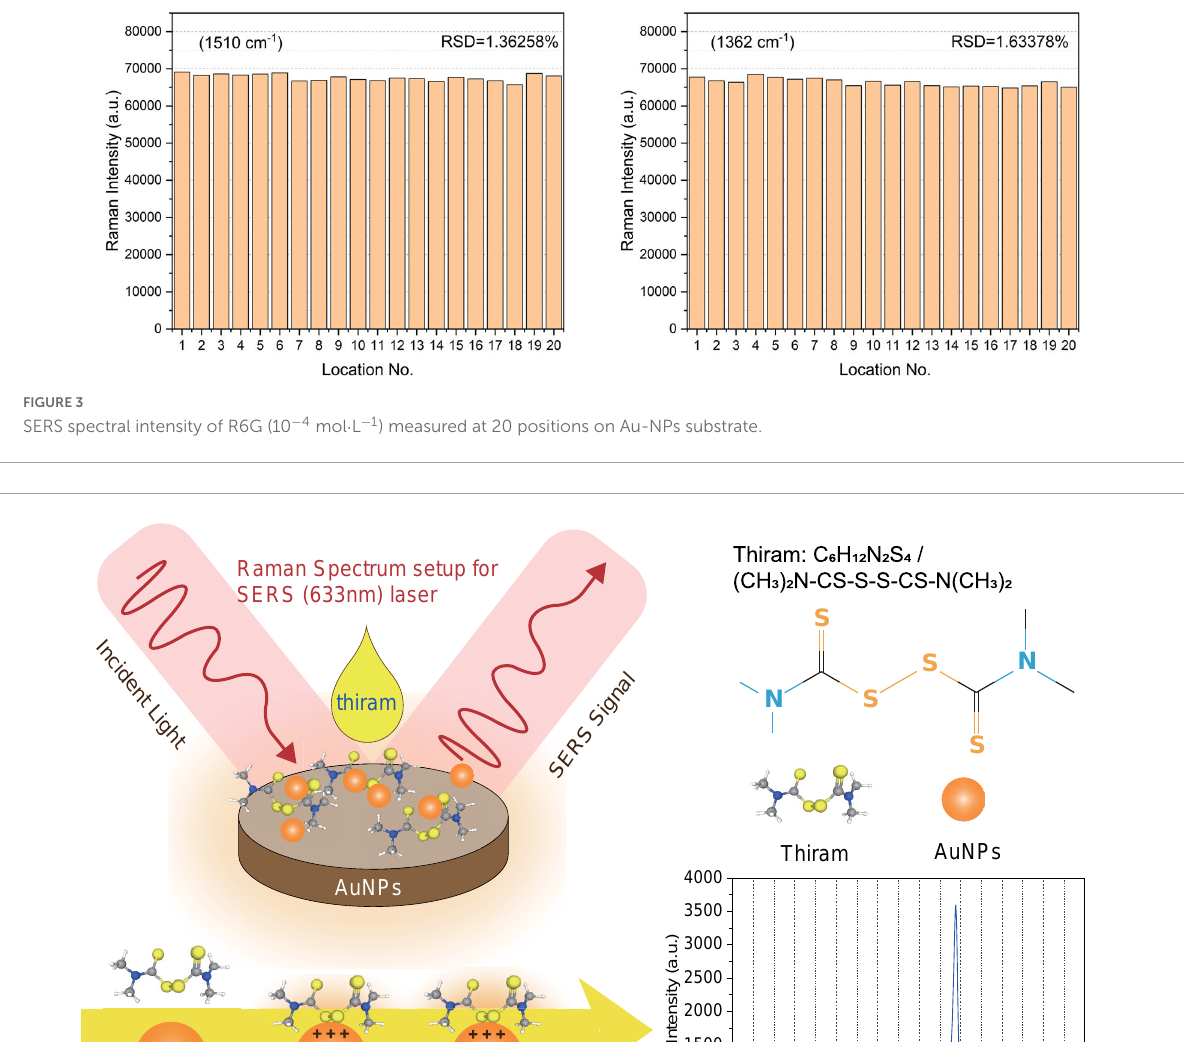
FIGURE4 Schematic diagram of the plasma SERS model with enhancement effect with reaction time for the solution of thiram and Au-NPs.